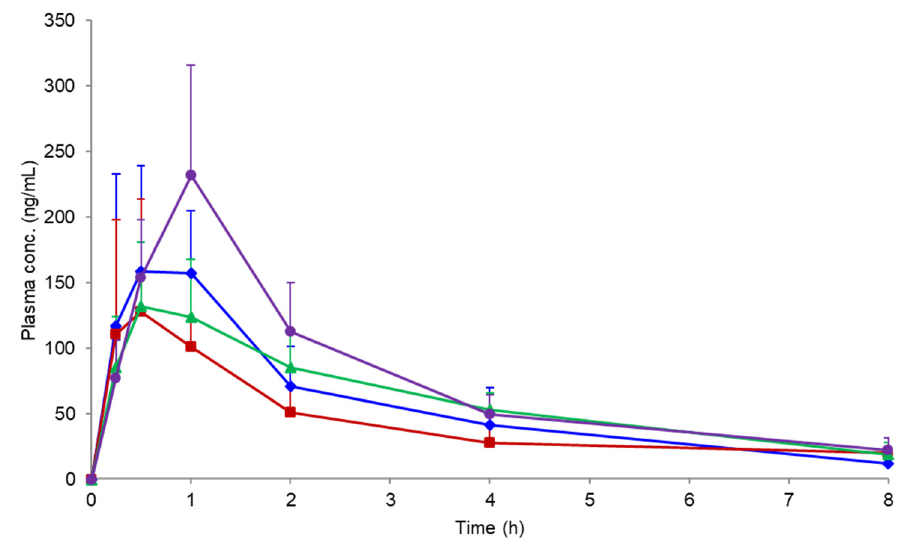
Figure 7. Plasma NFT concentration profiles after the oral administration of crystalline NFT and its ASDs in rats at a dose of 20 mg/kg ( n = 3). Symbols: crystalline NFT ( ◆ ), PVPVA ASD ( ■ ), HPMCAS ASD ( ▲ ), and Eudragit ASD ( ● ). Table 3. Pharmacokinetic parameters after the oral administration of NFT formulations.